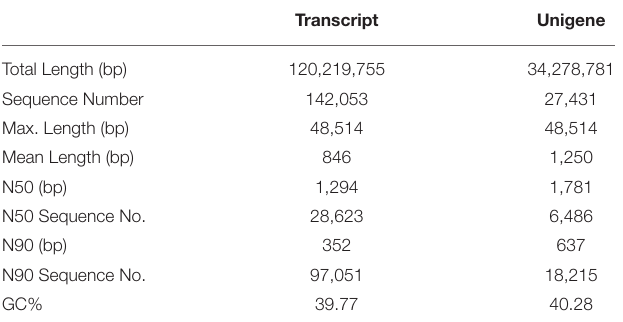
TABLE 1 | Characteristics of de novo assembly of the grasspea by Trinity software in this study.